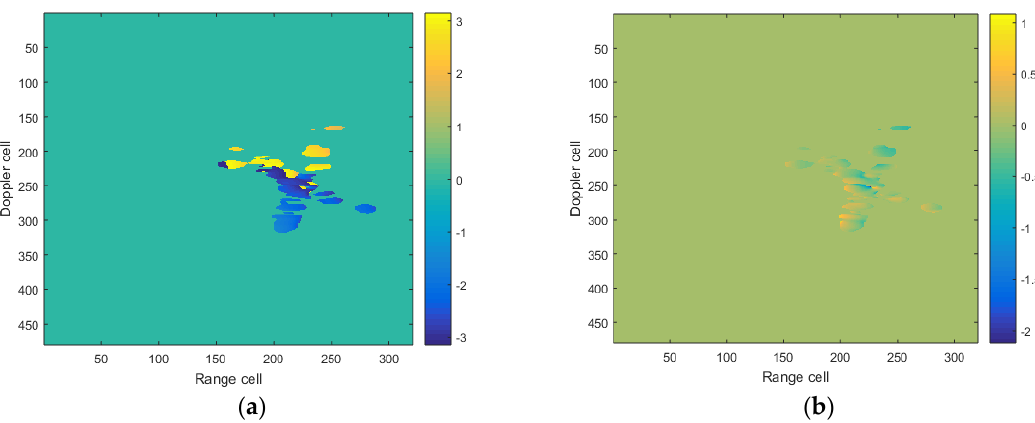
Figure 15. InPha images of measured InPhas: ( a ) from X- direction interferometry, the InPha is discontinuous as indicated by the abrupt change of colors between yellow and dark blue; ( b ) from Z- direction interferometry, the InPha is continuous as indicated by the gradual change of colors between yellow and light blue.